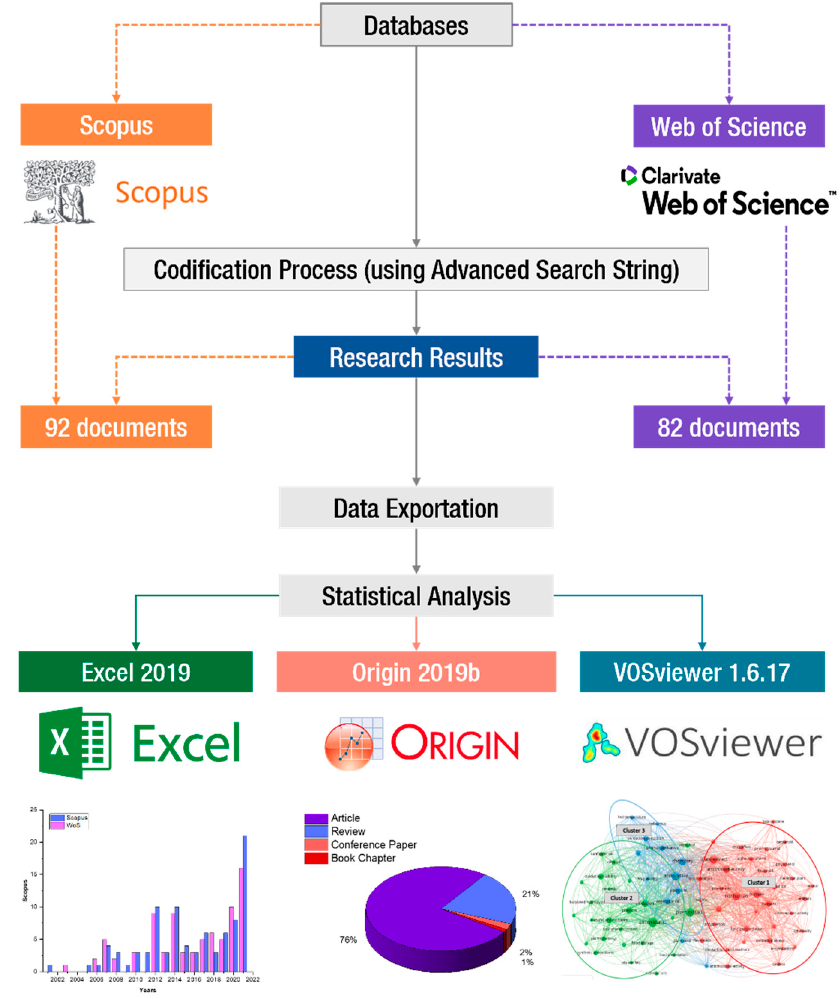
Figure 1. A scheme of bibliometric analysis methodology.